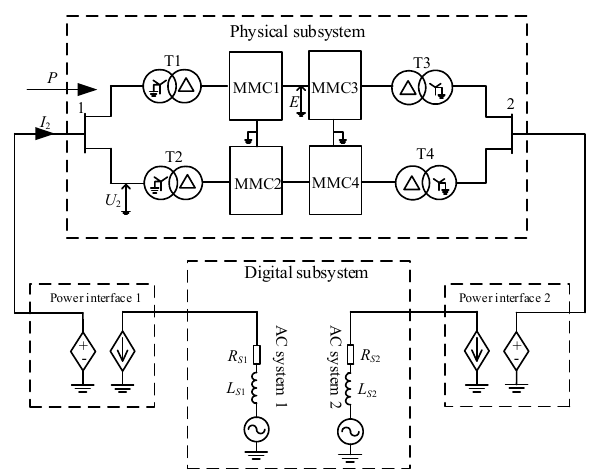
Figure 6. Structure of the simulation model.